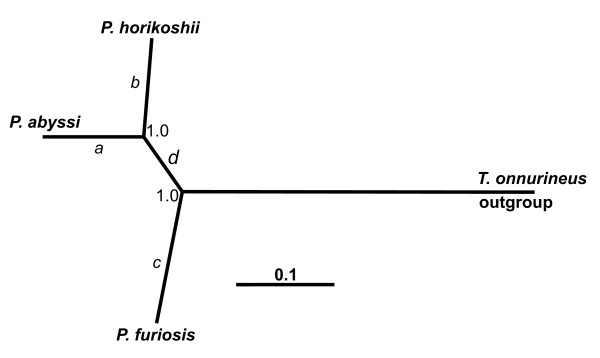
Phylogenetic relationships among the P. abyssi, P. horikoshii, P. furiosus, and T. onnurineus genomes based on the concatenated amino acid sequences. Bayesian posterior probabilities of nodes are shown. Ingroup branches are labeled a through d.